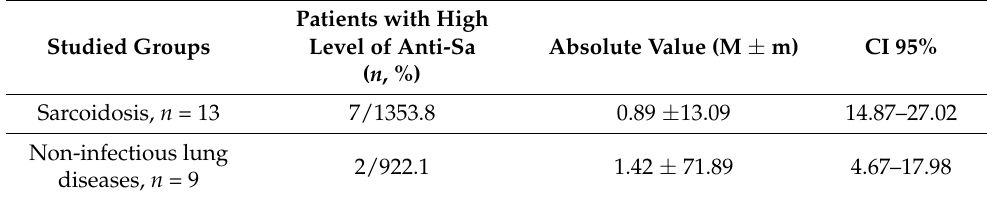
Table 3. Anti-citrullinated vimentin (anti-Sa) levels in patients with sarcoidosis and non-infectious lung